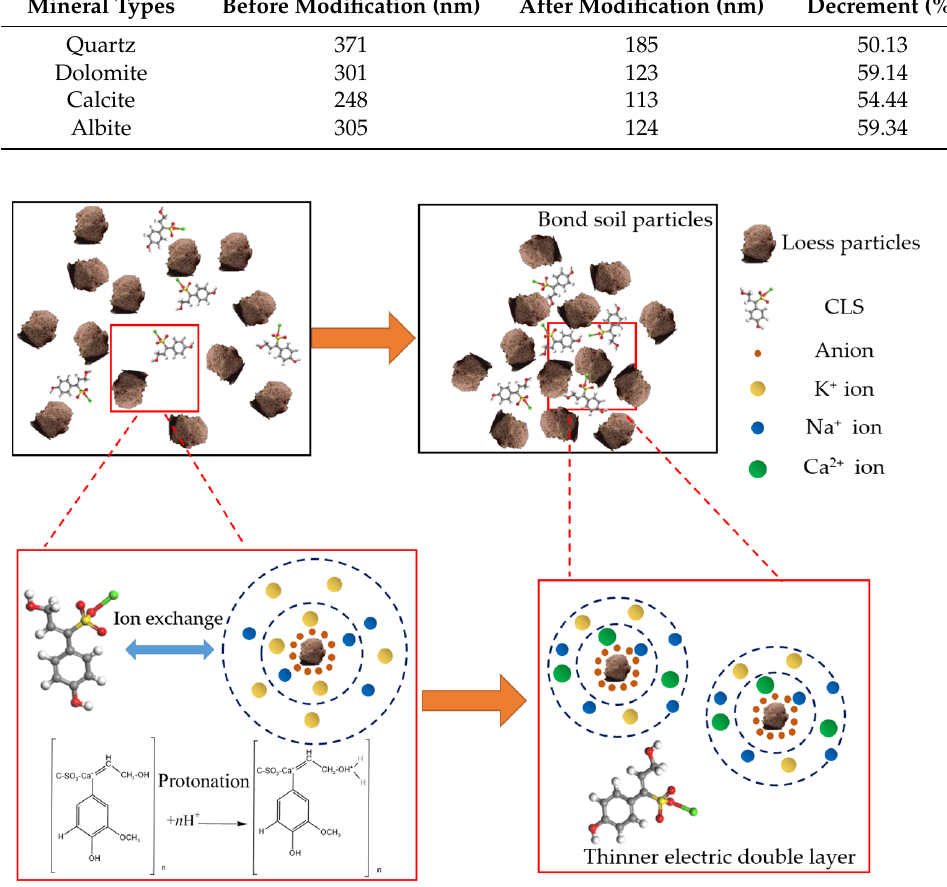
Figure 18. Schematic diagram of the mechanism of CLS improved loess.